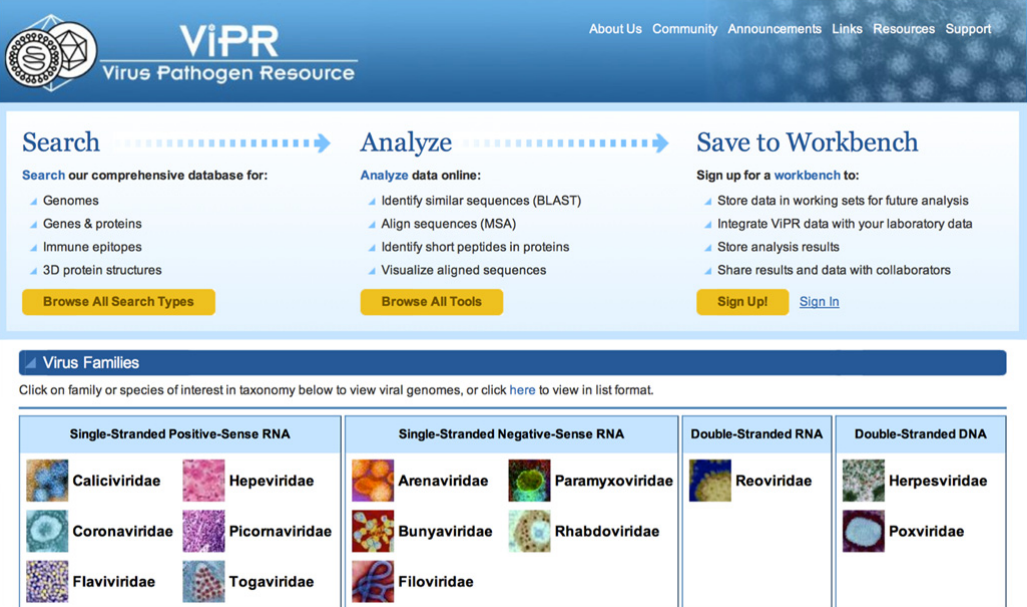
Figure 1. Virus Pathogen Database and Analysis Resource (ViPR) Homepage. ViPR serves as a gateway to search for information compiled from multiple sources, perform bioinformatics analyses, visualize data, and save results within the Workbench feature for the 14 virus families supported in the system, including Coronaviridae .